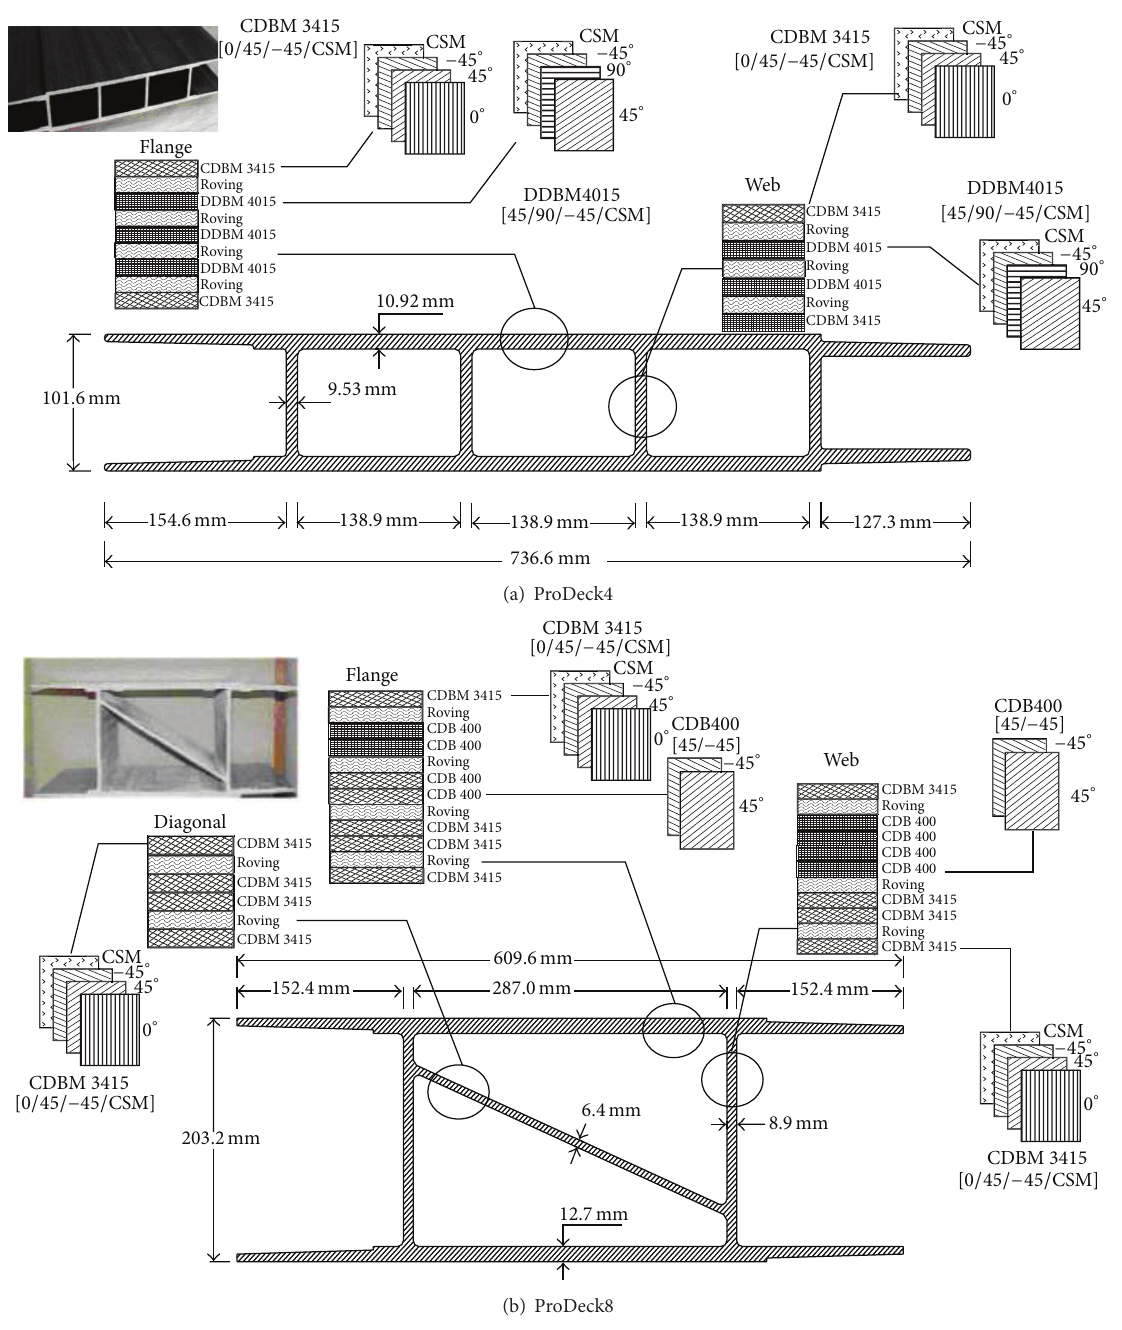
Figure 1: Fiber architecture and stacking